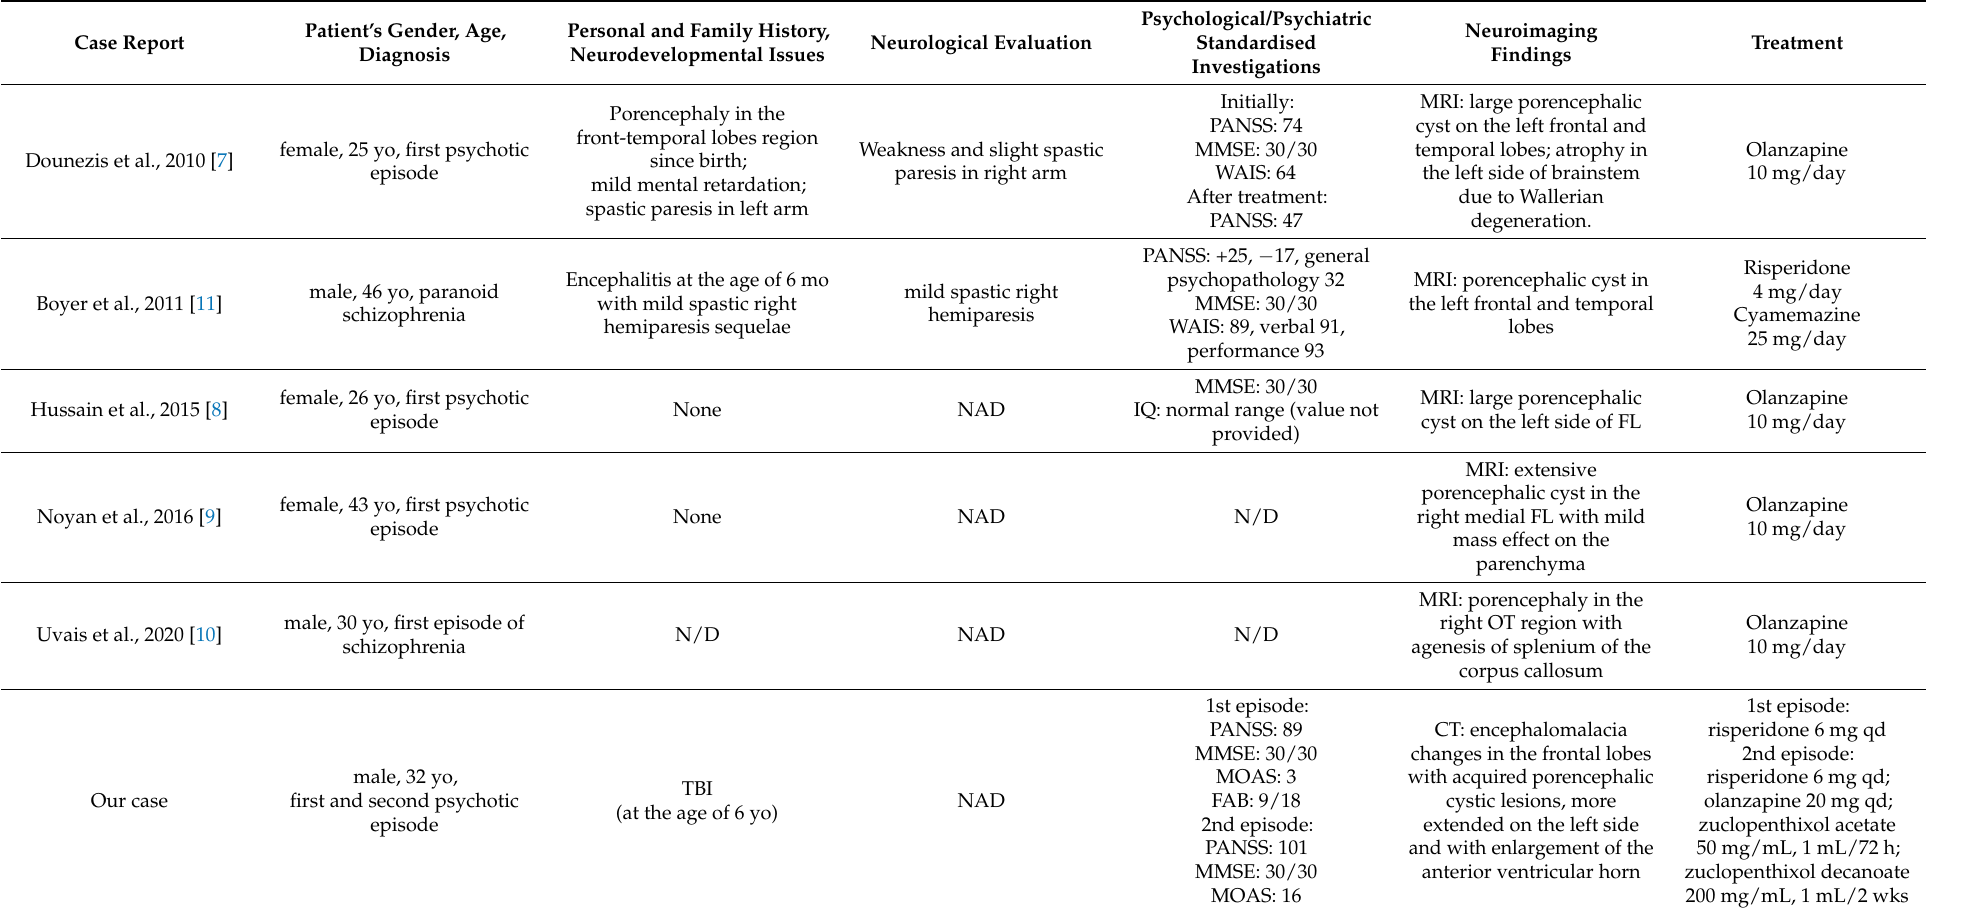
Table 1. Case reports of porencephaly associated with psychosis in the